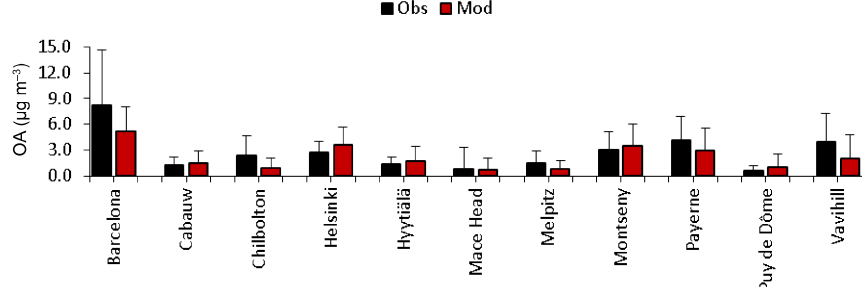
Figure 3. Observed (black) and modelled (VBS_BC_NEW) (red) average OA mass at AMS sites for the period between 25 February and 26 March 2009.